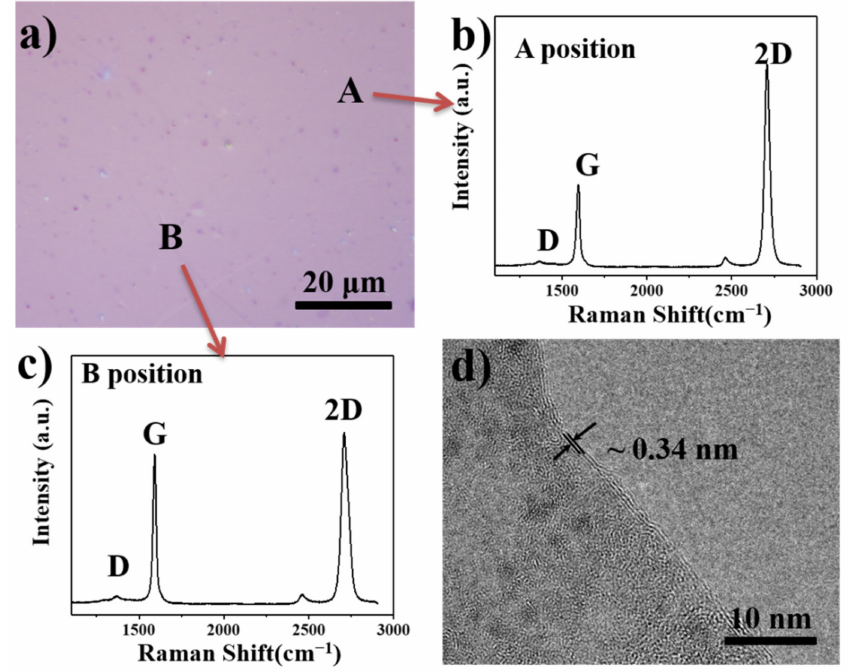
Figure 1. ( a ) SEM image of GS, Raman spectra of the area marked ( b ) A and ( c ) B in ( a ). and ( d ) HRTEM image of